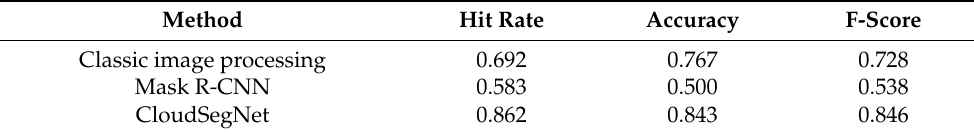
Table 5. Evaluation of the investigated cloud detection